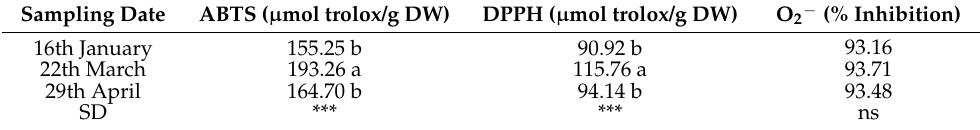
Table 6. Effects of temporal variations on the antioxidant capacity measured in strawberry